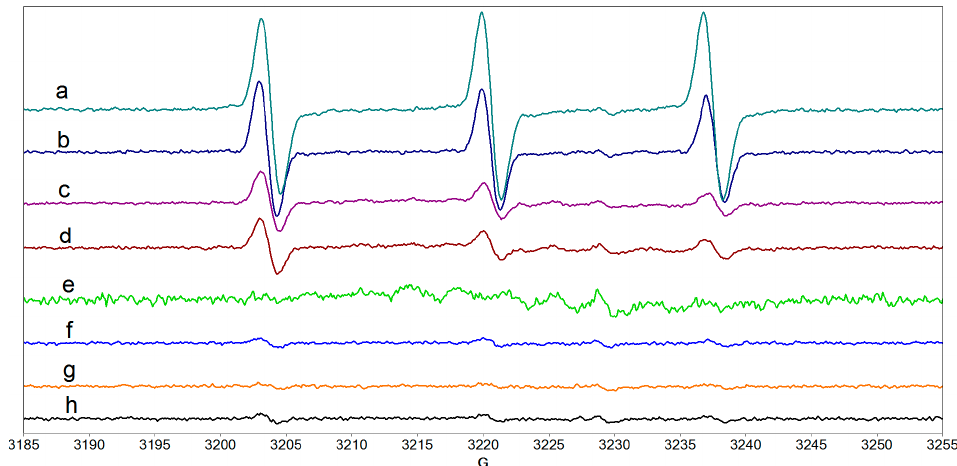
Figure 12. The EPR spectra of TEMPONE formed after UVA irradiation of the following systems: ( a ) water, ( b ) collagen/riboflavin, ( c ) collagen, ( d ) Peschke solution, ( e ) tears, ( f ) collagen/hyaluronic acid, ( g ) collagen/hyaluronic acid/HSA/LF, ( h )